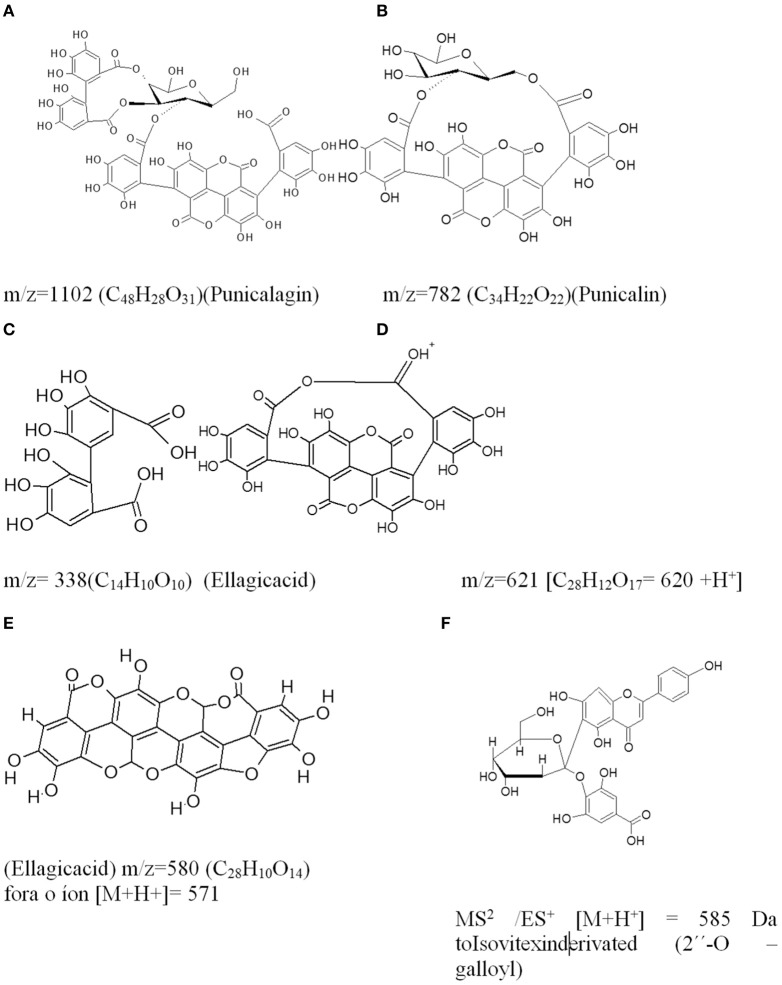
Structures proposed by the results of the MS/MS/ES+ analysis for ions detected at RTs ranging from 9.2 to 11.5 min in SF10-FBuOH. (A) The pseudomolecular ion [M+H+] = 1,103 (RT = 9.2 min) and molecular mass of M = 1,102 for the molecular formula C48H28O31, which was identified as an ellagitannin acid derivative of punicalagin. (B) The pseudomolecular ion [M+H+] = 783 (RT = 9.3 min) with a molecular mass of M = 782 for molecular formula C34H22O22, identified as punicalin. (C) The pseudomolecular ion [M+H+] = 338 M for the formula C14H10O10, which was identified as ellagic acid dihydrate. (D,E) Ellagic acid derivative. (F) Isovitexin derivative (2″-O –galloyl).